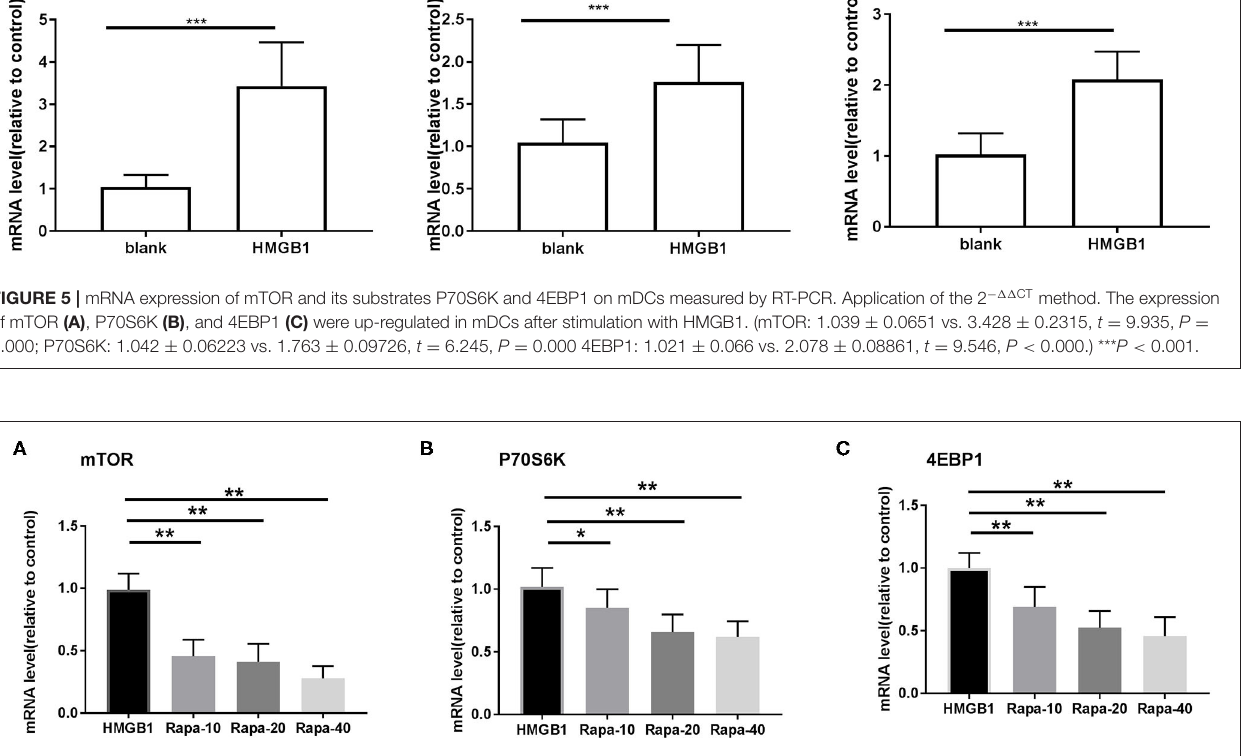
FIGURE 6 | mRNA expression of mTOR and its substrates P70S6K and 4EBP1 in mDCs under different concentrations of rapamycin (Rapa-10: 10ng/ml; Rapa-20: 20ng/ml; Rapa-40: 40ng/ml) intervention by RT-PCR. Application of the 2 − 11 CT method. The expression of mTOR (A) , P70S6K (B) , and 4EBP1 (C) were significantly decreased in mDCs through Rapa intervention. * p < 0.05, ** p <